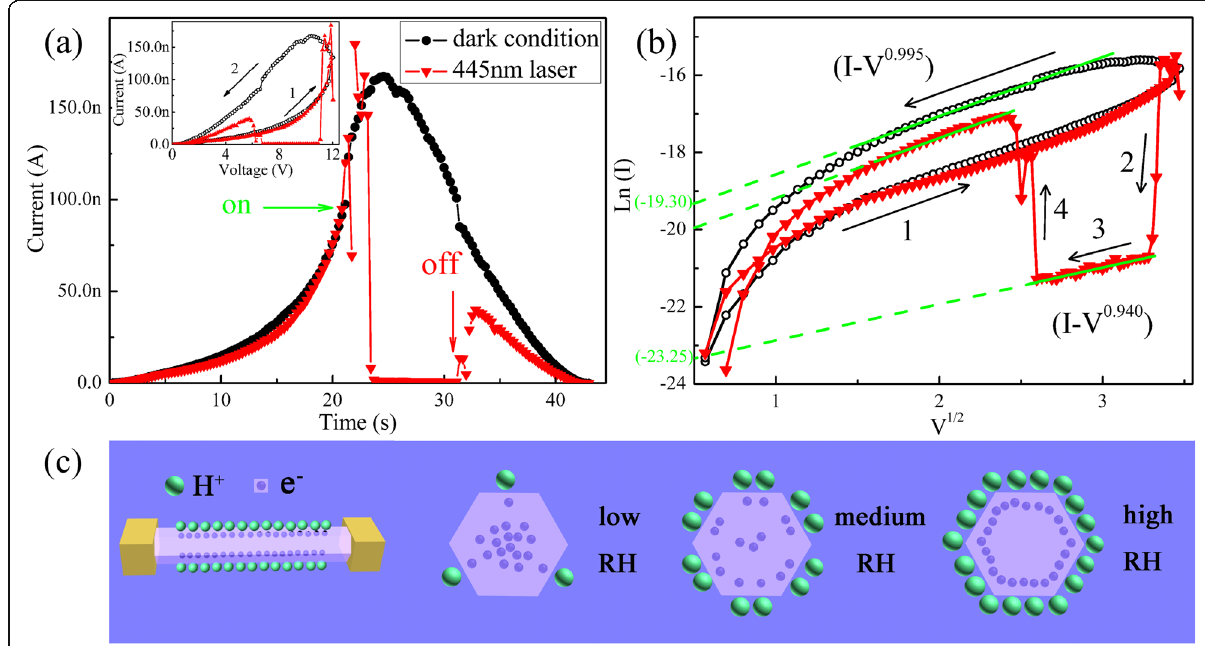
Fig. 2 a I-T curves recorded on a bias sweep range of 12 V in the dark and under illumination (445 nm, 500 mW) at 70% RH. b The plots of ln(I) versus V 1/2 . c Diagram of the mechanism of the NPC of the WO 3 NW. The inset of a : the I-V curves on a bias sweep range of 12